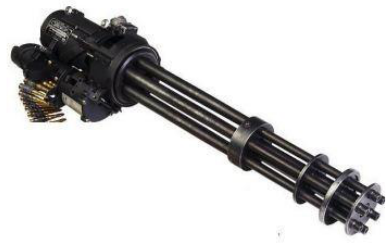
Figure 1. M134 Gatling gun.